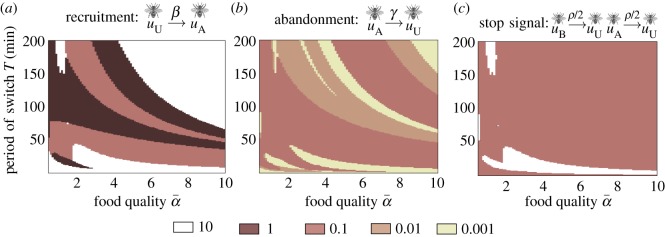
Tuning (a) recruitment β; (b) abandonment γ; and (c) social inhibition ρ to maximize the reward rate (RR) in the indiscriminate stop-signalling model. The best tunings of parameters vary considerably with the recruitment being mostly low.